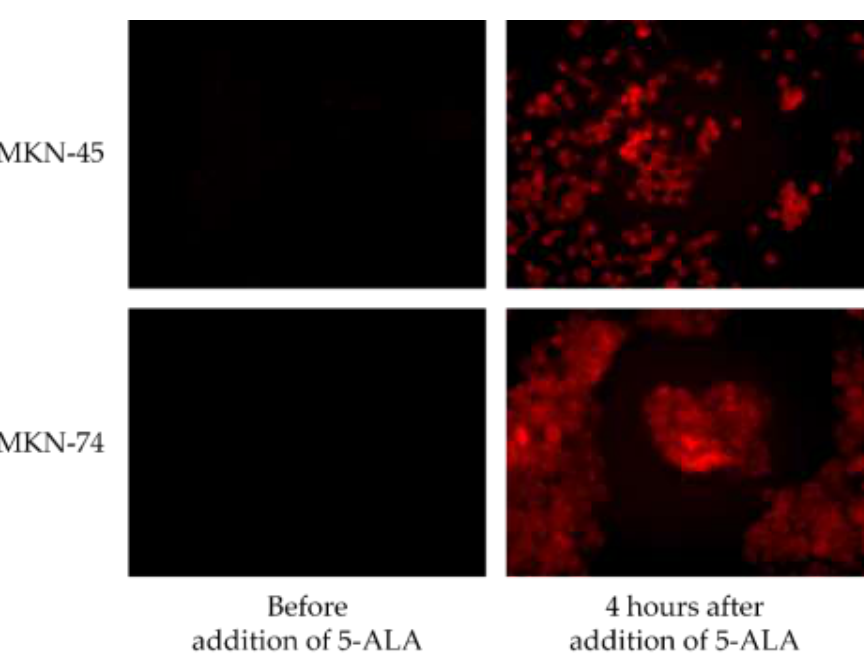
Figure 1. Gastric cancer cell lines supplemented with 5-ALA and irradiated with 410 nm excitation light.